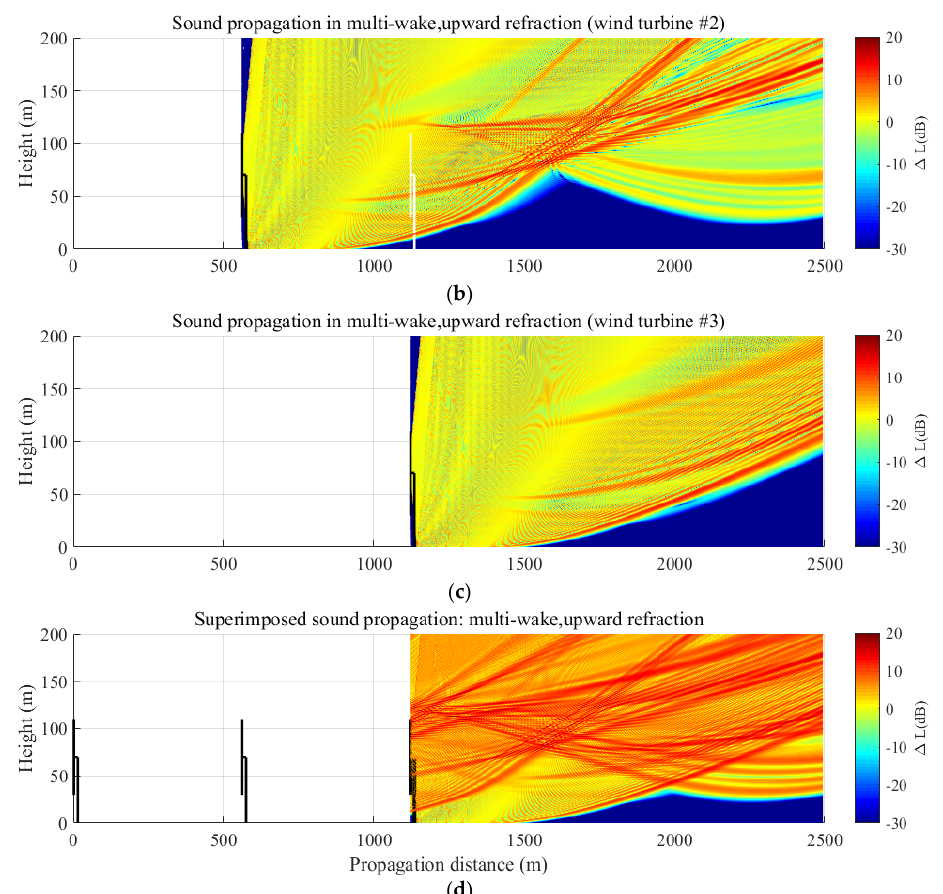
Figure 17. RSPL simulated at f = 1000 Hz and b = − 3: ( a ) ANPropagation by wind turbine #1 downstream of the wakes of wind turbines # 1, 2, 3; ( b ) ANPropagation by wind turbine #2 downstream of the wakes of wind turbines #2, 3; ( c ) ANPropagation by wind turbine #3 downstream of the wakes of wind turbine #3; ( d ) superimposed RSPL from all wind turbines #1, 2, 3. Appl. Sci. 2018 , 8 , x FOR PEER REVIEW